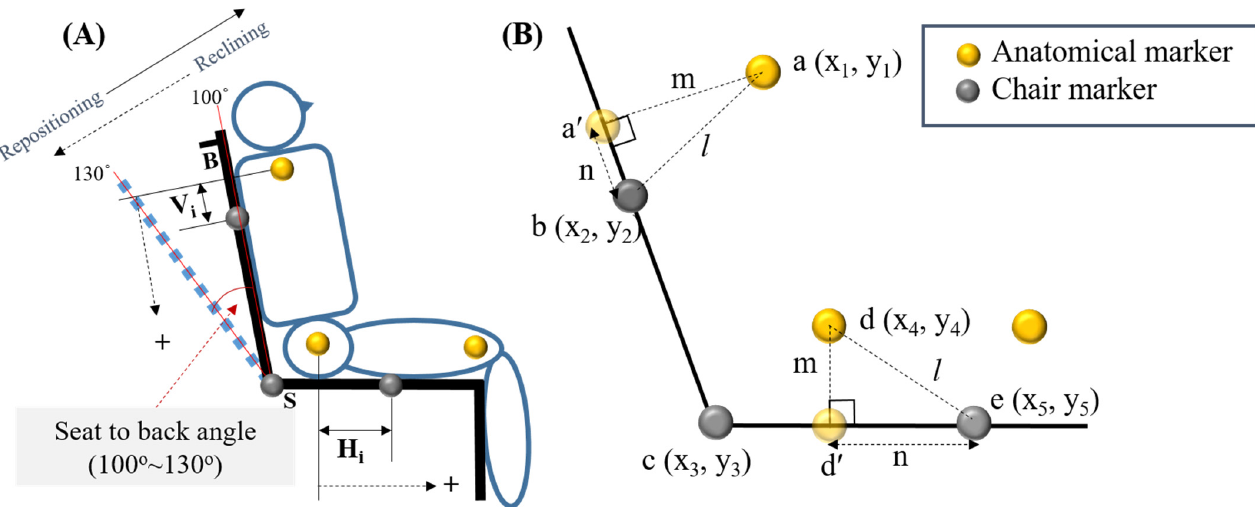
Figure 4. Schematic diagram of marker attachment locations ( A ) and body-slip calculation ( B ). Vi, distance between refer- ence point B and the acromion marker along the backrest plane; Hi, distance between the reference point S and the greater trochanter marker along the seat plane; BS, backrest sliding; SS, seat sliding; m, perpendicular distance between the ana- tomical marker and the chair; l, straight-line distance between the anatomical marker and chair marker; n, distance be- tween the anatomical marker projected on the chair and the chair marker.